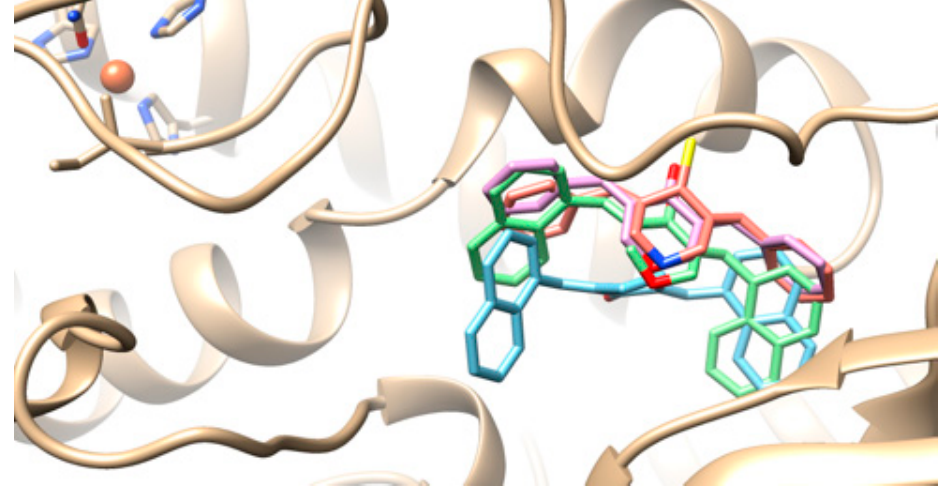
Figure 7. Putative binding modes of compounds 1k (blue), 1l (purple), 1m (green), and 1o